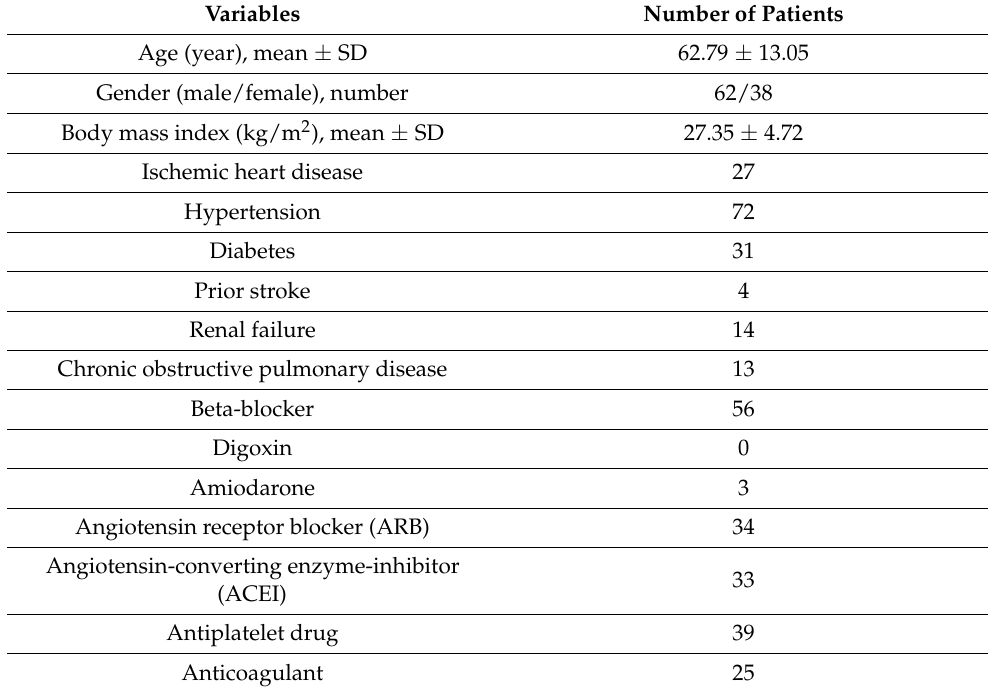
Table 1. Patient baseline characteristics.